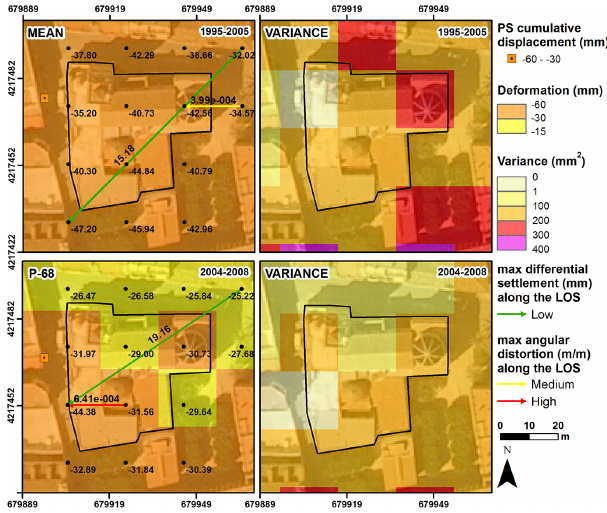
Figure 11. Mean (1995–2005), 68th percentile (2004–2008) and variance for both studied periods in the vicinity of the Santas Justa and Rufina